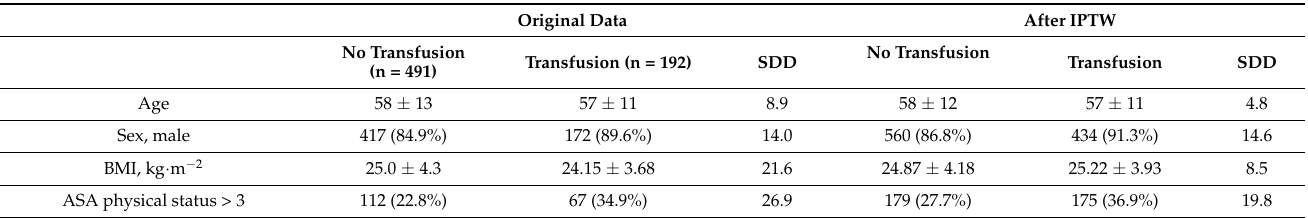
Table 1. Baseline characteristics for patients receiving a blood transfusion or not during the perioper- ative period of curative resection for head and neck